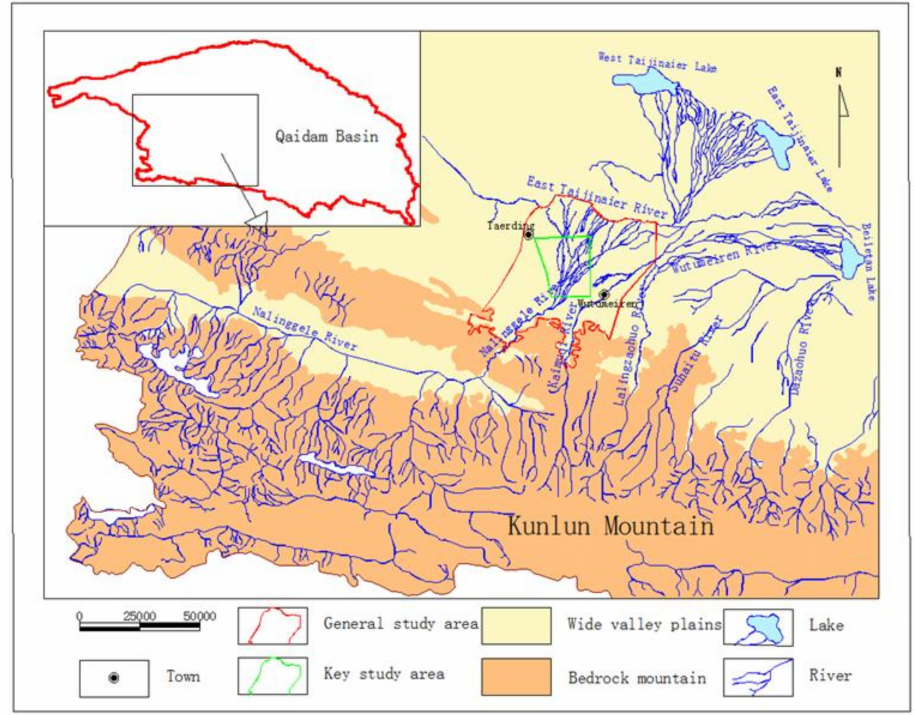
Figure 2. Sketch map of the study